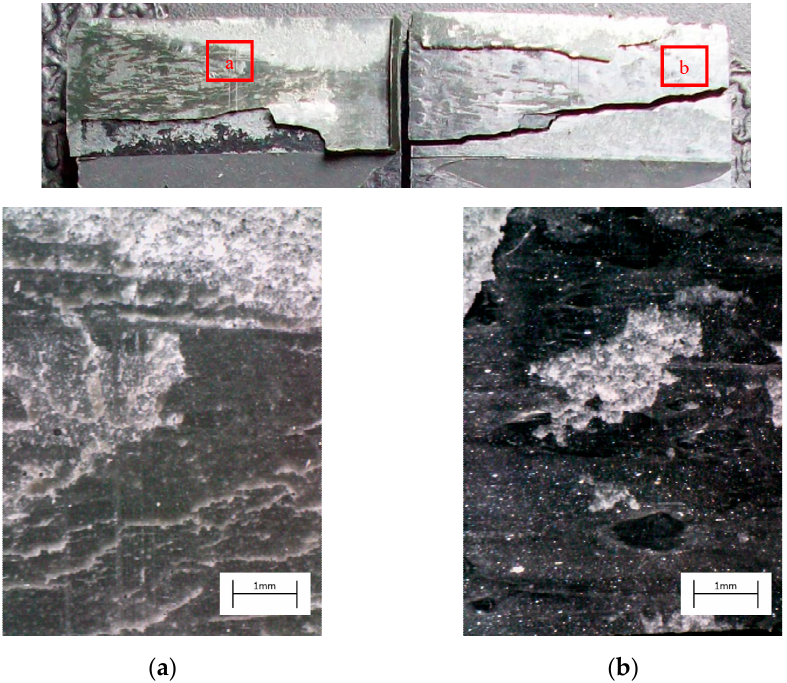
Figure 13. Fracture surface of a specimen pretreated with APPT with D = 5 mm and v = 200 mm/s and subjected to the quasi-static tensile test, with magnified details ( a ) and ( b ) acquired by microscope.